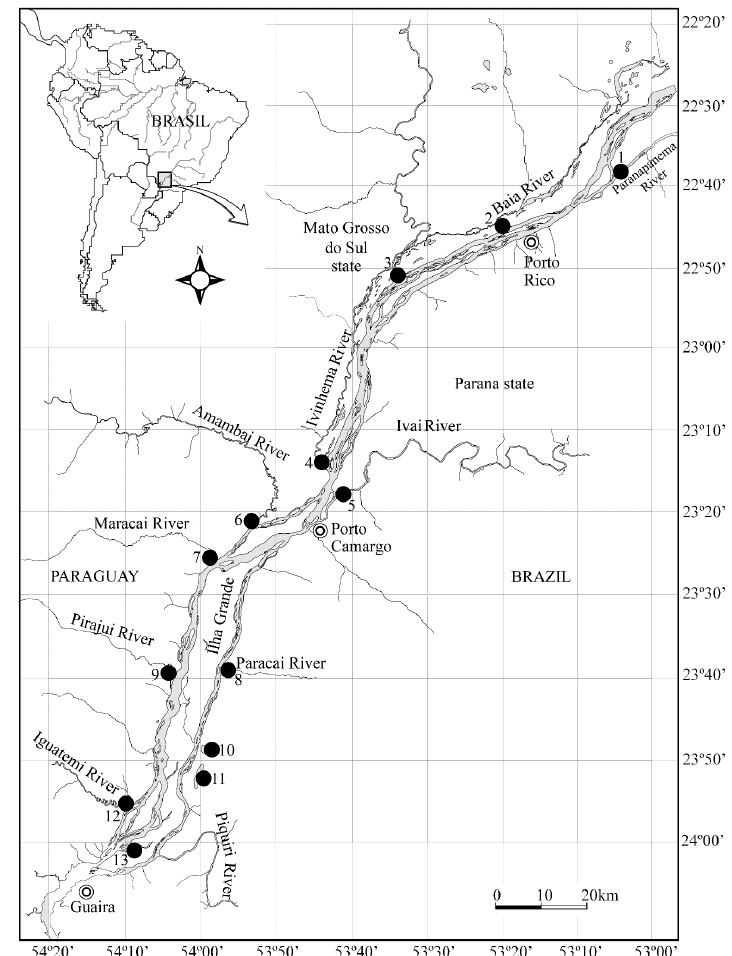
Figure 1. Sampling sites in the Upper Paraná River floodplain. Paraná River in grey. (1) Paranapanema; (2) Baía; (3) Ivinhema; (4) Ivinheminha; (5) Ivaí; (6) Amambai; (7) Maracaí; (8) Paracaí; (9) Pirajuí; (10) São João lagoon; (11) Xambrê lagoon; (12) Iguatemi; (13) Saraiva lagoon. Sampling sites in the main channel of the Paraná River were located upstream from each point in the map (except for 10 and